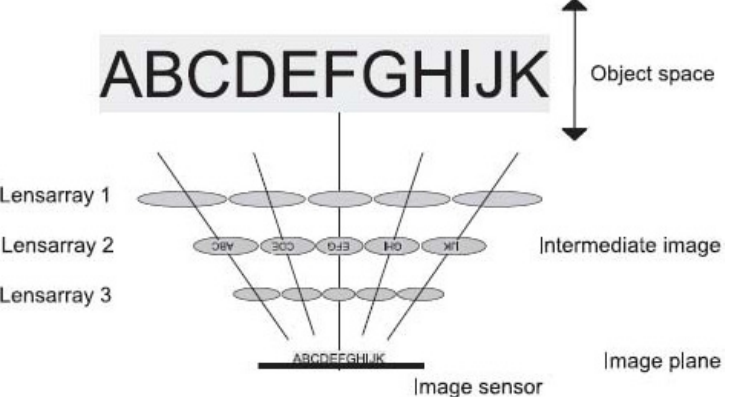
Figure 5. The working principle of the Cley system. Reproduced with permission from [32] © The Optical Society.